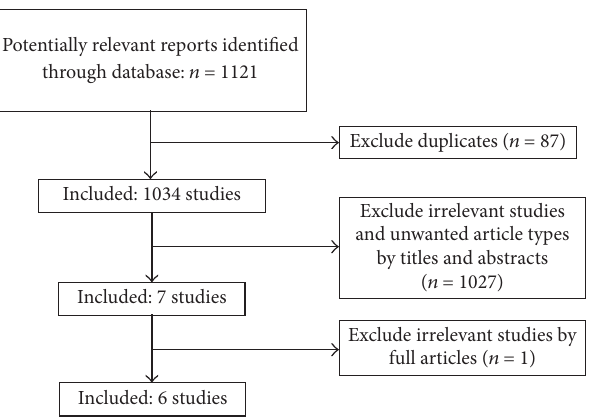
Figure 1: Flow diagram of searching and selection for included systematic